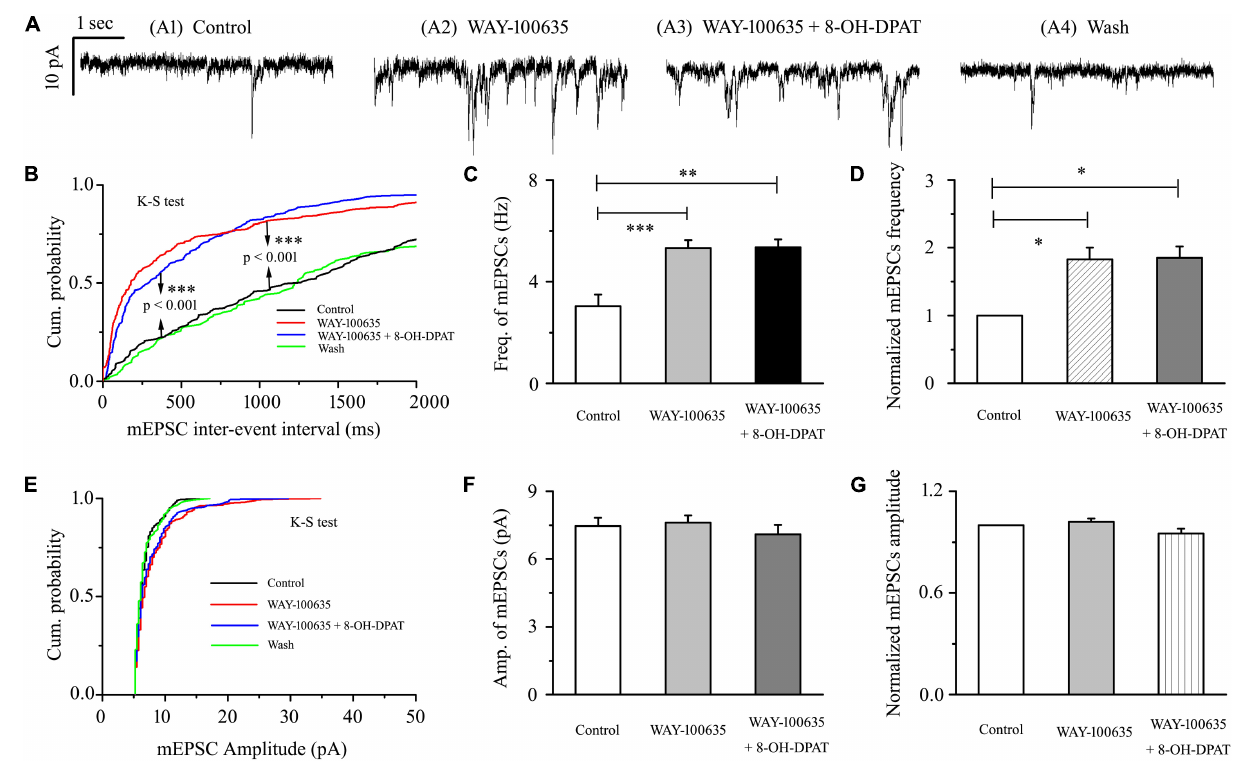
FIGURE 7 | 8-OH-DPAT-induced decreases in the frequency of mEPSCs in OFF-type RGCs were blocked by WAY-100635. (A) Representative recordings showing that WAY-100635 prevented 8-OH-DPAT-induced changes in mEPSC frequency. (A1) Control condition; (A2) during WAY-100635 treatment; (A3) during WAY-100635 + 8-OH-DPAT treatment; (A4) recovery. (B,E) Cumulative interevent interval and amplitude distributions of the mEPSCs in a representative neuron during control recording and during WAY-100635 and WAY-100635 + 8-OH-DPAT application. WAY-100635 and WAY-100635 + 8-OH-DPAT significantly shifted the distribution of interevent intervals to the left (B) but did not shift the distribution of mEPSC amplitudes (E) . The WAY-100635 and WAY-100635 + 8-OH-DPAT-induced changes in the distribution of interevent intervals and amplitudes were statistically significant ( n = 8). ∗∗∗ p < 0.001, Kolmogorov–Smirnov test. Summarized data for the frequency (C) and amplitude (F) of the mEPSCs ( n = 9). (D,G) Normalized mEPSC frequency and amplitude ( n = 9). ∗ p < 0.05, ∗∗ p < 0.01, and ∗∗∗ p < 0.001,